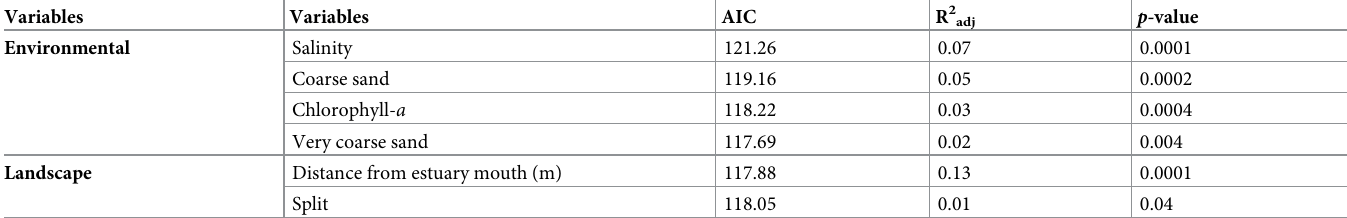
Table 2. Environmental and landscape variables selected by forward selection method on fish assemblage β -diversity. Adjusted R 2 values indicated variation explained of each variable in each subset for db-RDA analysis.